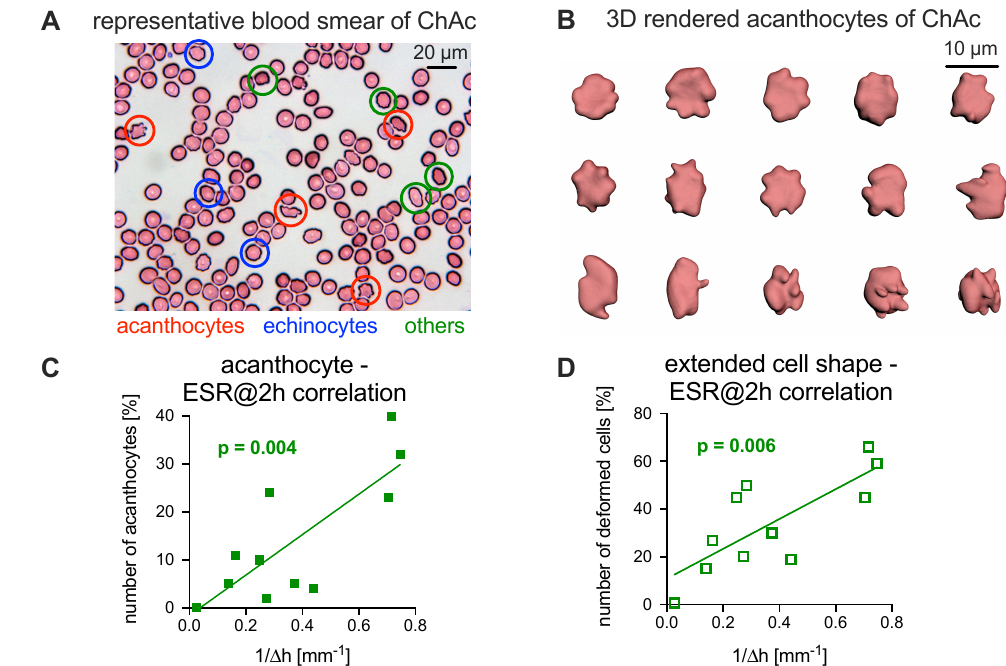
Figure 2. Relation of acanthocyte counts to ESR. ( A ): A representative stained blood smear of a ChAc patient. ( B ): Representative 3D-rendered acanthocytes from the freshly fixed blood of a ChAc patient. ( C ): Plot of the number of acanthocytes vs. the inverse of the ESR at 2 h and the corresponding correlation analysis. ( D ): Plot of the number of all deformed erythrocytes (echinocytes, acanthocytes, and other unspecified cell shapes) vs. the inverse of the ESR at 2 h and the corresponding correlation analysis. Panels C and D contain measurements from nine patients (cp. Table 1), where one patient was measured twice (independent blood sampling on different days). Since none of the controls presented with acanthocytes, they are summarized in one data point with their average ESR. The plotted line represents the linear regression. The analysis reveals a significant correlation for both parameters (panels C and D, R 2 coefficients of 0.61 and 0.59,